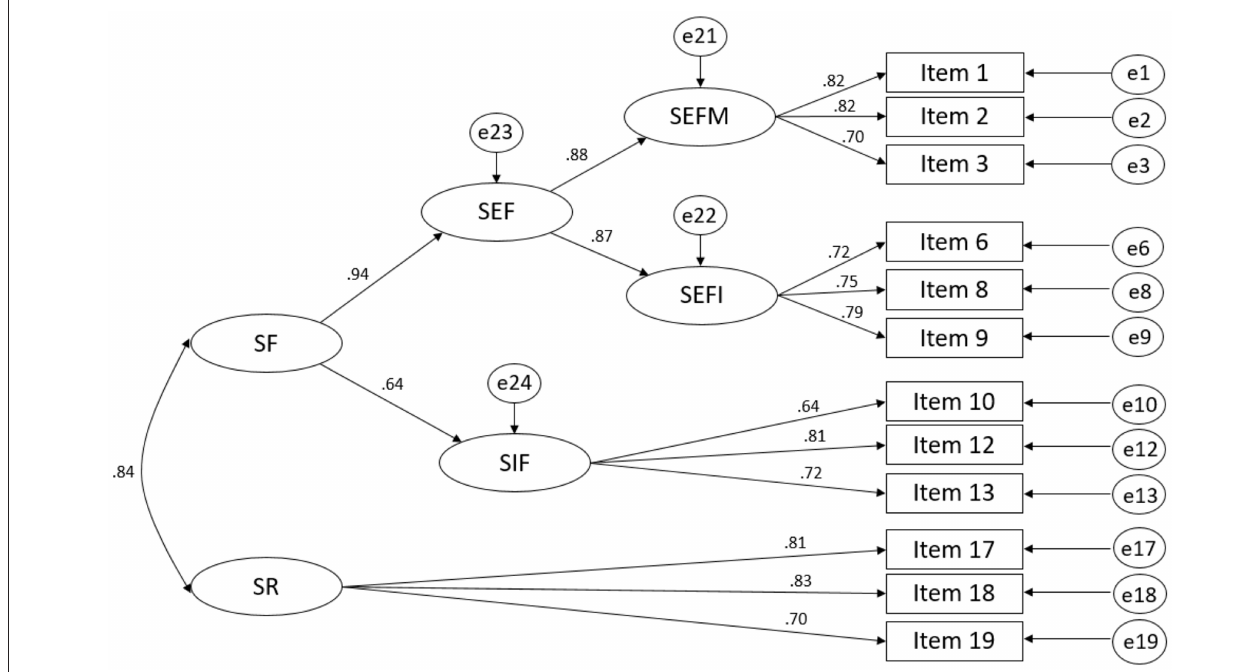
FIGURE 2 | Model 1 for the SaPS-SF with standardized factor loadings.